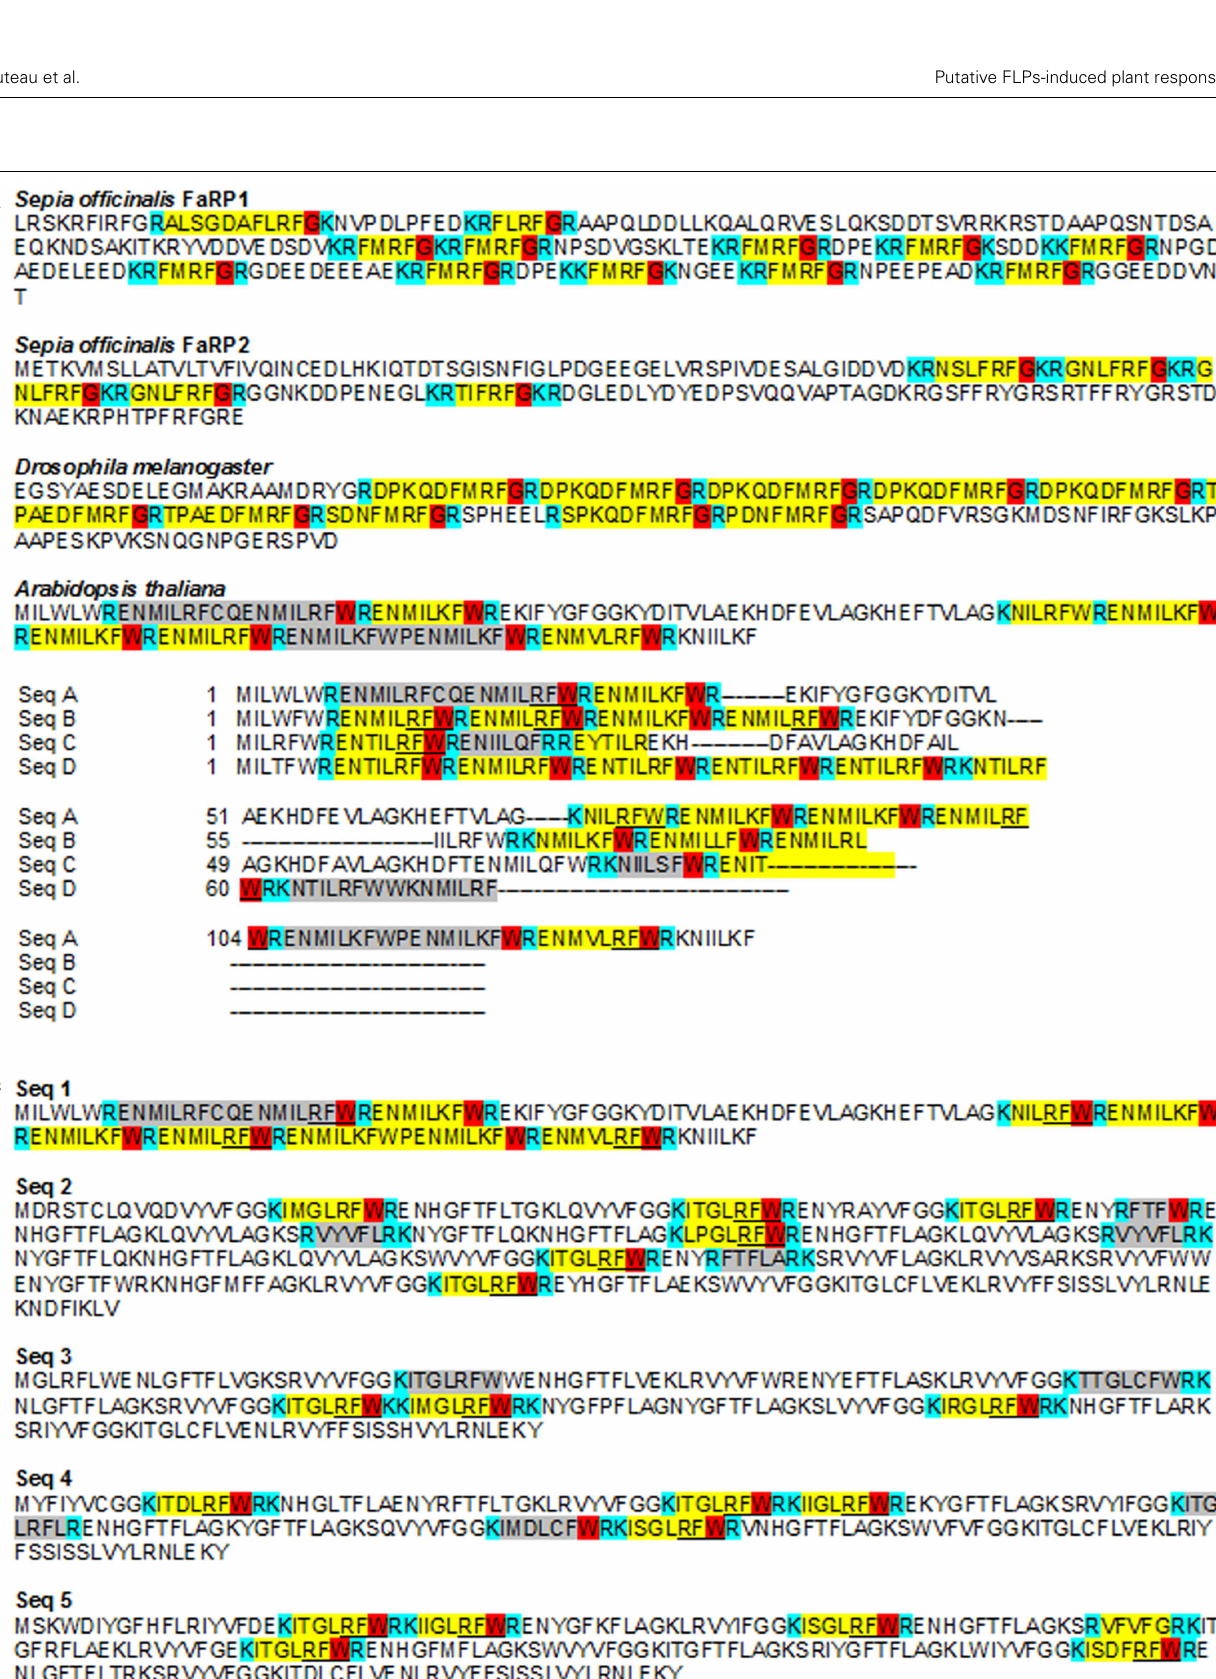
FIGURE 2 | FMRFamide-like peptides sequences in metazoans and Arabidopsis thaliana . (A) Partial sequences of FLPs from Sepia officinalis (Mollusca), Drosophila melanogaster (Arthropoda), and Arabidopsis thaliana